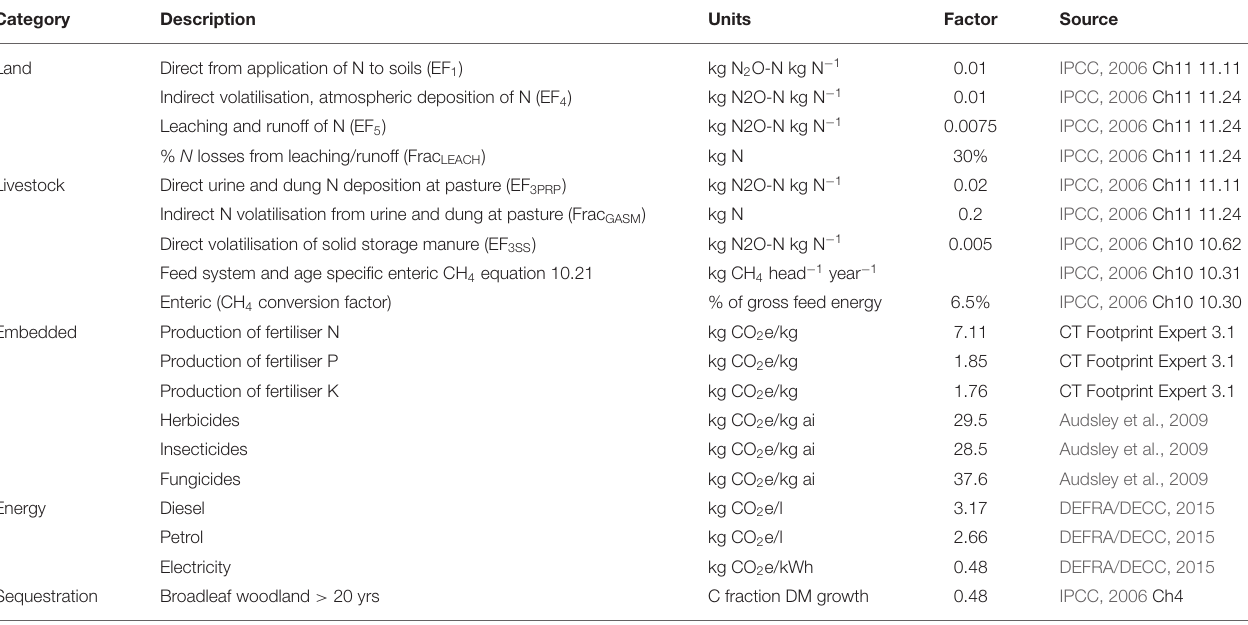
TABLE 5 | Selected emission factors and calculations applied within the model.